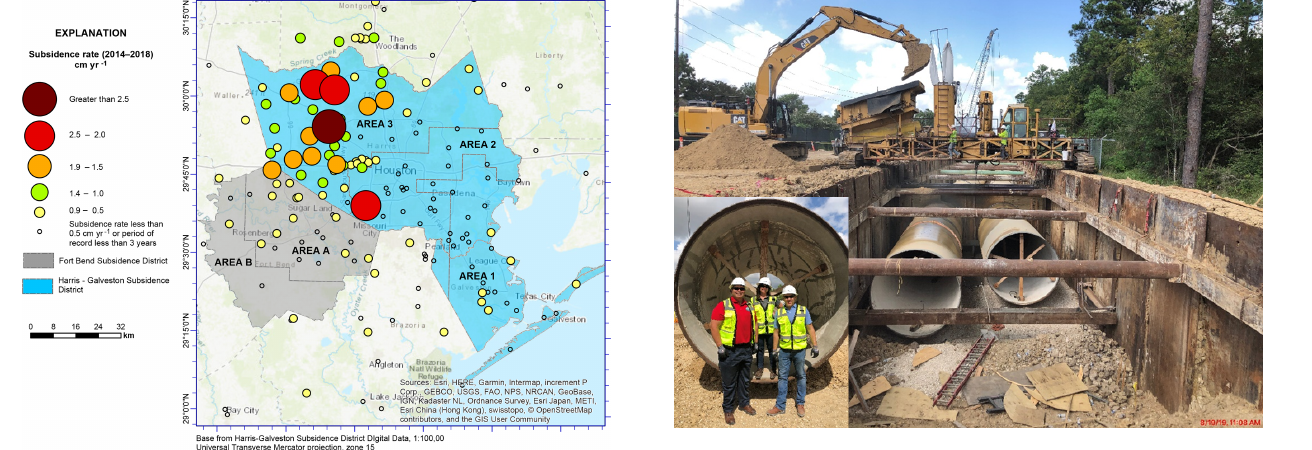
Figure 4. (main) Photo of construction of dual 2.74m raw wa- ter lines from Lake Houston to the Northeast Water Purification Plant ( courtesy Steve Berckenhoff ); (inset) Subsidence District of- ficials near raw water pipeline ( courtesy Harris-Galveston Subsi- dence District